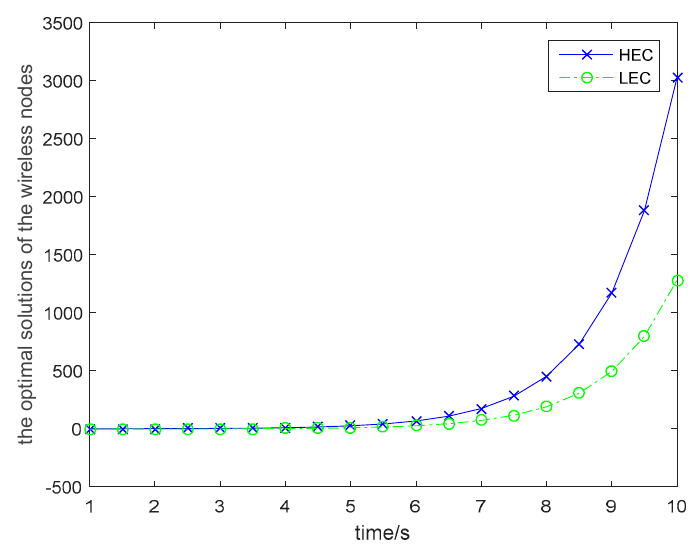
Figure 6. Optimal solutions of the wireless nodes.